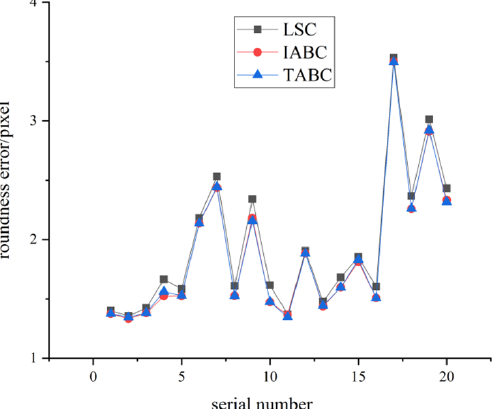
Table 3. Coordinates of data points in the existing literature.